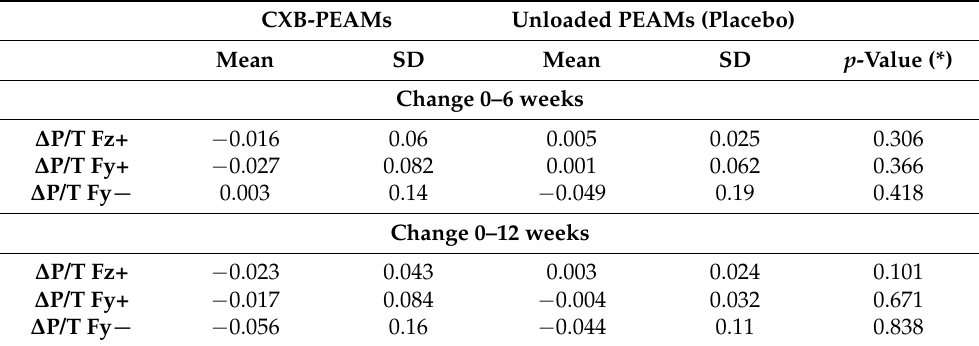
Table 5. Force plate analyses in 30 dogs with degenerative lumbosacral stenosis, treated with intradis- cal injection of celecoxib-polyesteramide microspheres (CXB-PEAMs) or unloaded PEAMs